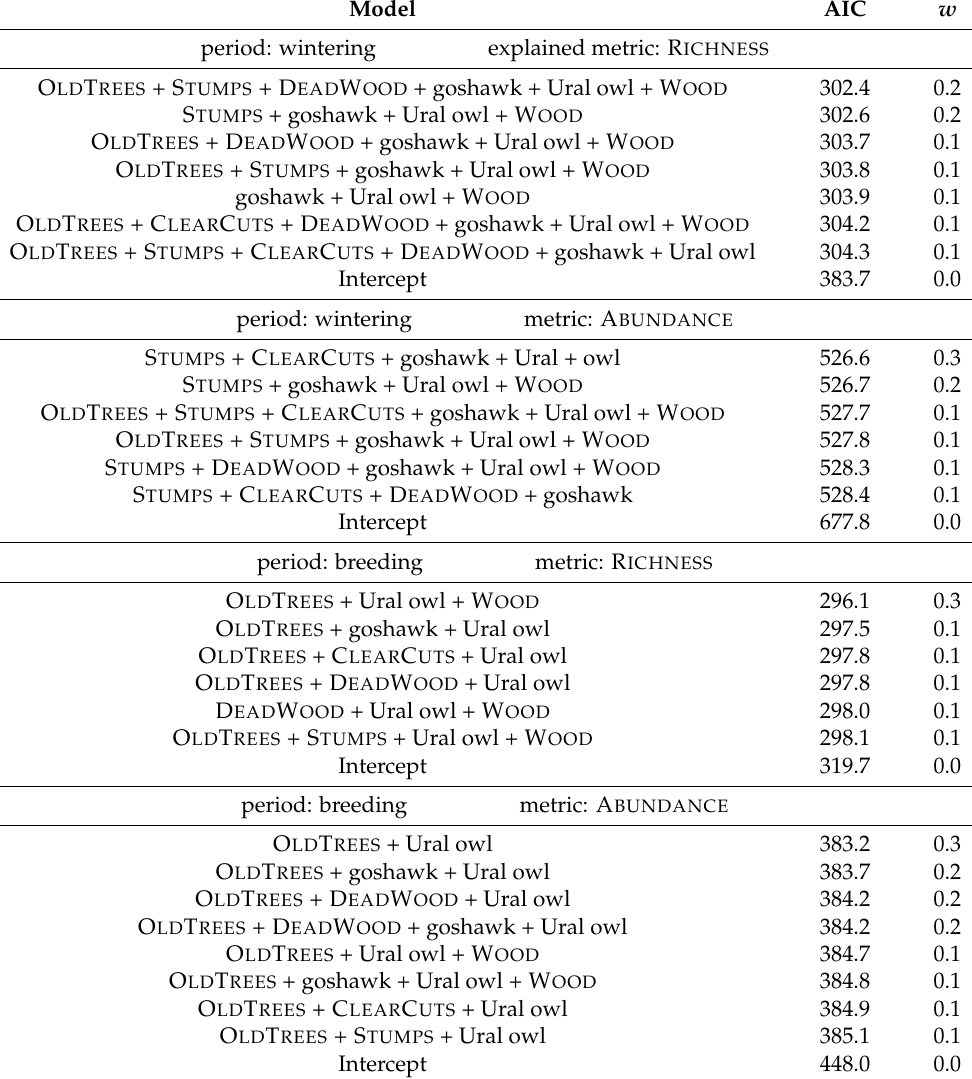
Table 4. Sets of Generalized Linear Models explaining bird diversity metrics calculated for wintering and breeding periods based on selected environmental variables and occurrence of apex predators (goshawks and Ural owls). AIC—Akaike Information Criterion, w —AIC weight. Only models with ∆ AIC < 2 are presented. Model AIC w period: